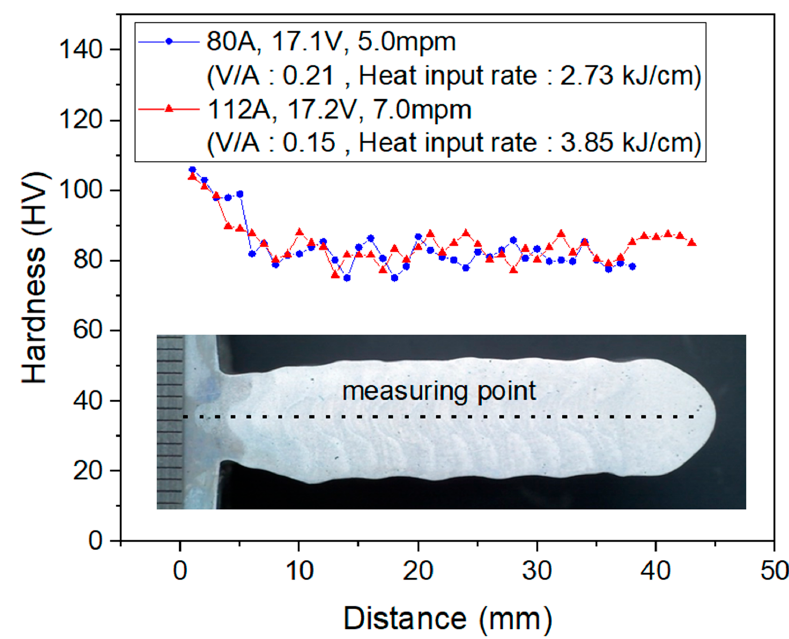
Figure 12. Hardness comparison by the difference between the current and voltage ratio and heat input rate. input